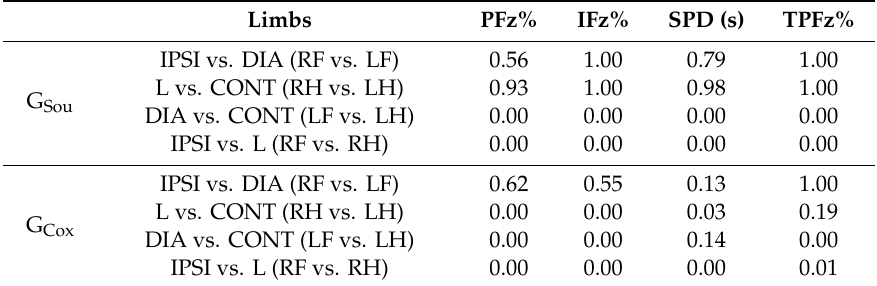
Table 3. The p values of the PFz%, IFz%, SPD (s), and TPFz% comparing the front and hind limbs within groups. Limbs PFz% IFz% SPD (s) TPFz%